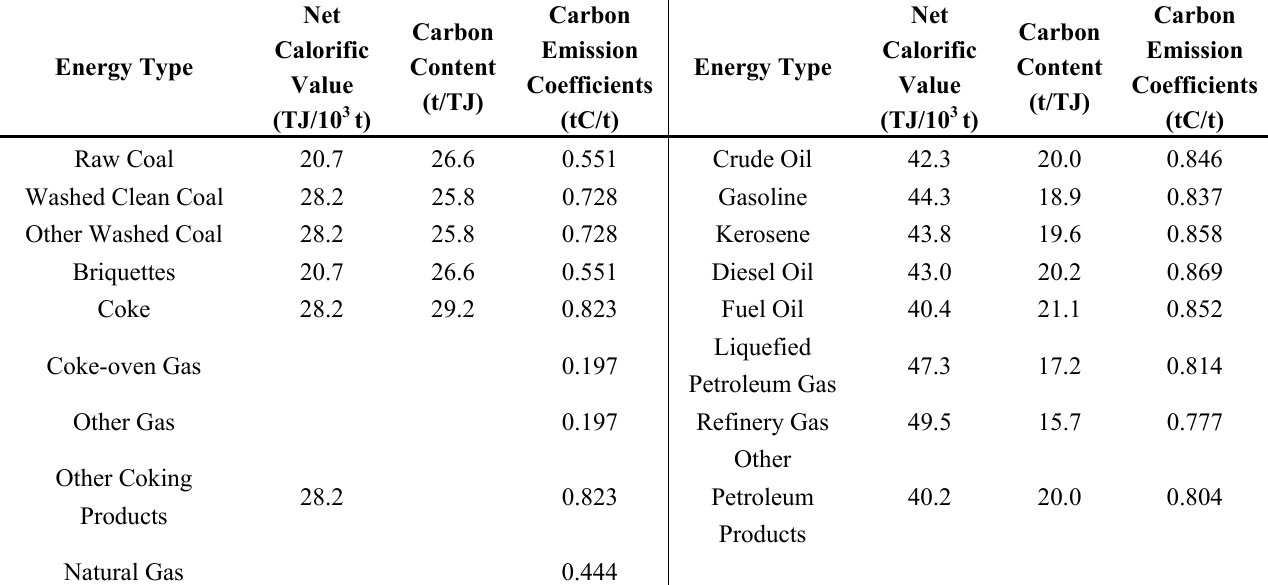
Table 1. Carbon emission coefficients of different kinds of